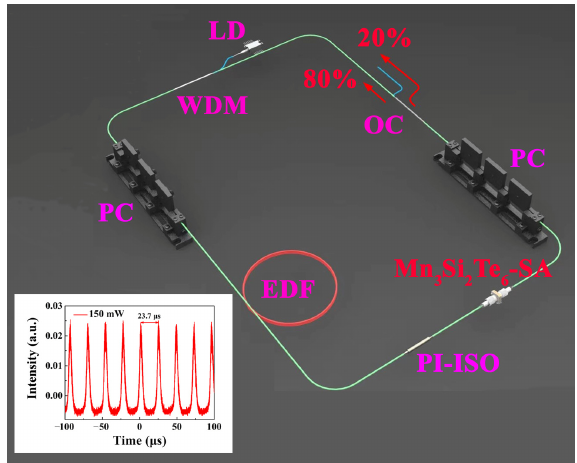
Figure 4. The schematic diagram of the pulsed fiber laser.